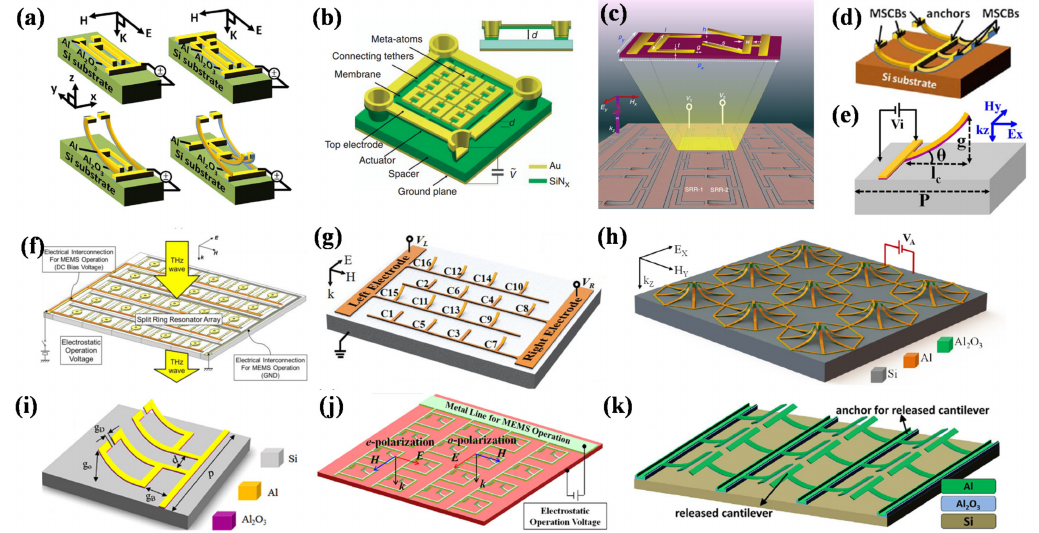
Figure 4. ESA-based vertical tuning methods of metamaterial: ( a ) schematic of DSRR with single-side and double-side ESA structure under unreleased and released state, respectively [66]; ( b ) schematic of the unit cell of the THz absorber [67]—the vertical distance between the meta-atoms and the ground plane can be tuned electrostatically; ( c ) colored SEM image of the MEMS Fano metasurface [68]—the periodic unit cell comprises of two SRRs; ( d ) schematic of electric split-ring resonators with movable stress-curved beams (eSRR-MSCBs) after microstructures are released [69]; ( e ) schematic of an upward bent microcantilever as metamaterial unit cell [70]; ( f ) MEMS reconfigurable SRR design array of the unit cell [71]; ( g ) schematics of a bandwidth tunable MEMS metamaterial supercell formed by a 4 × 4 array of microcantilever resonators with varying fixed and released lengths [72]; ( h ) schematics of the proposed uniaxially isotropic MEMS metamaterial with eight released cantilevers in an octagon ring [73]; ( i ) schematics of the conductively coupled MEMS metamaterial [74]; ( j ) schematics of the chained eSRR array with a metal line connecting the eSRRs for MEMS operation [75]; ( k ) schematic of the mirrorlike T-shape metamaterial (MTM) device after release